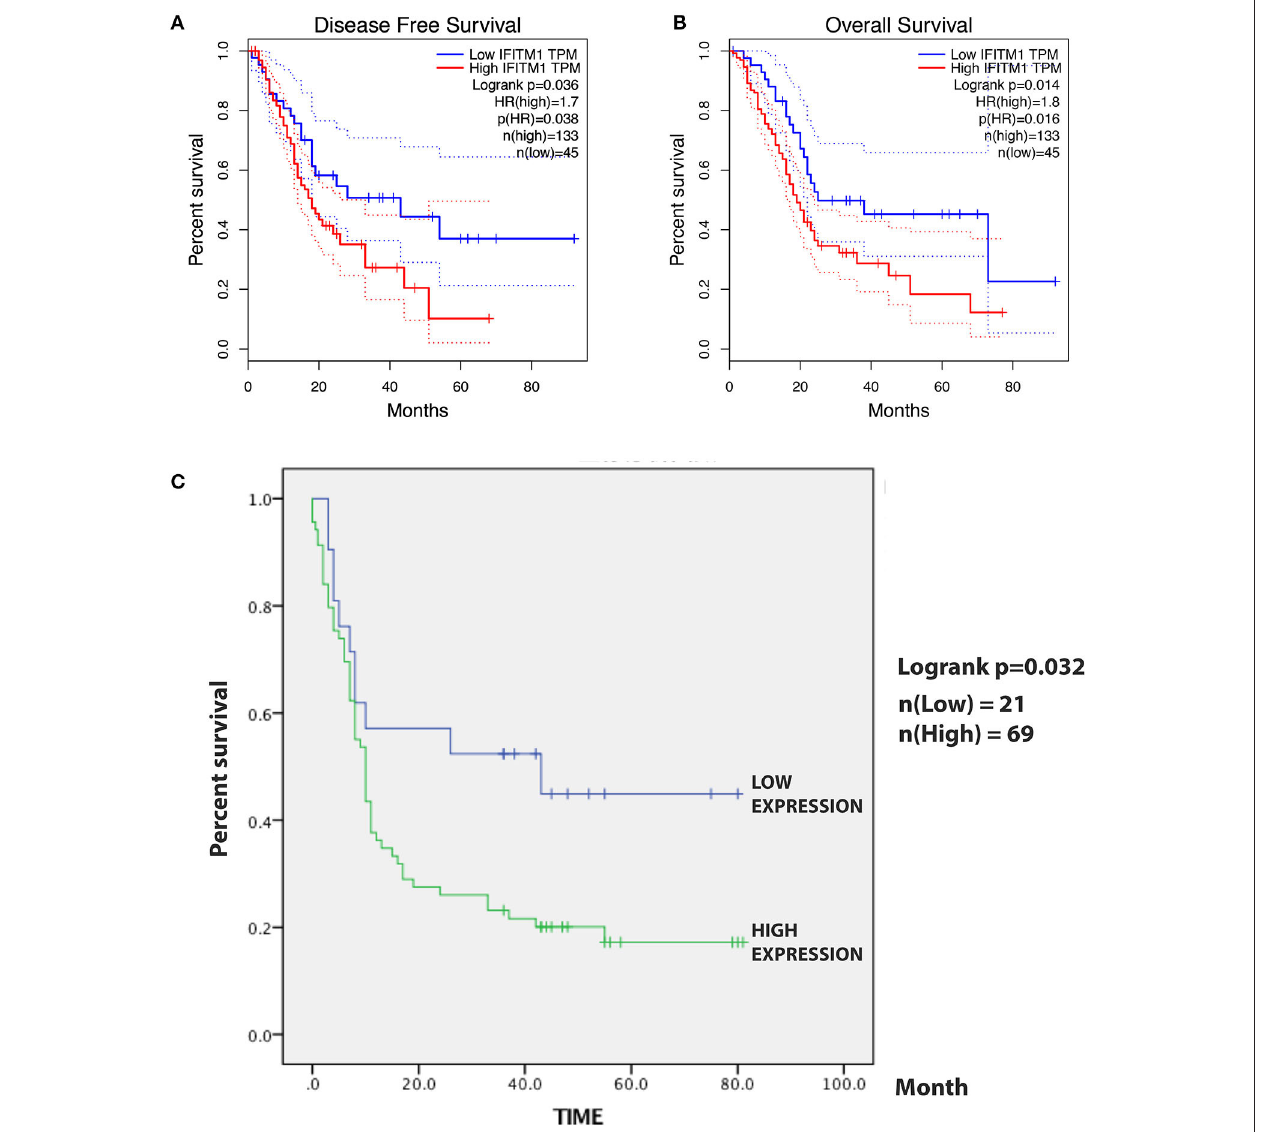
FIGURE 6 | The prognostic value of different expressed IFITM1 in patients with pancreatic cancer. (A) Kaplan–Meier curve for the disease-free survival of patients with pancreatic cancer with low vs. high expression of IFITM1 [median progression-free survival (PFS) < 20 months vs. more than 20 months, respectively; log-rank test, p = 0.036]. (B) Kaplan–Meier curve for the overall survival (OS) of patients with low vs. high expression of IFITM1 (log-rank test, p = 0.016). (C) Kaplan–Meier curve for the 90 patients with pancreatic cancer in our study.